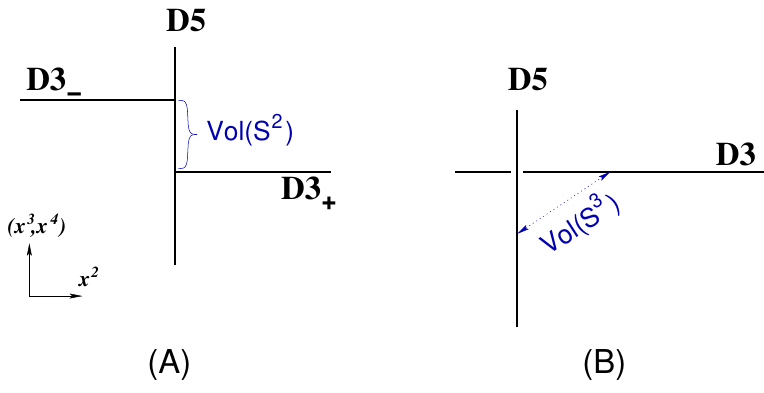
Figure 19 . Two phases of a 2d N = (0 ; 2) interface (5.7) in a 3d N = 2 theory (3.11). illustrated in (cid:12)gure 19, is the possibility of D3-brane(s) splitting into two pieces along the